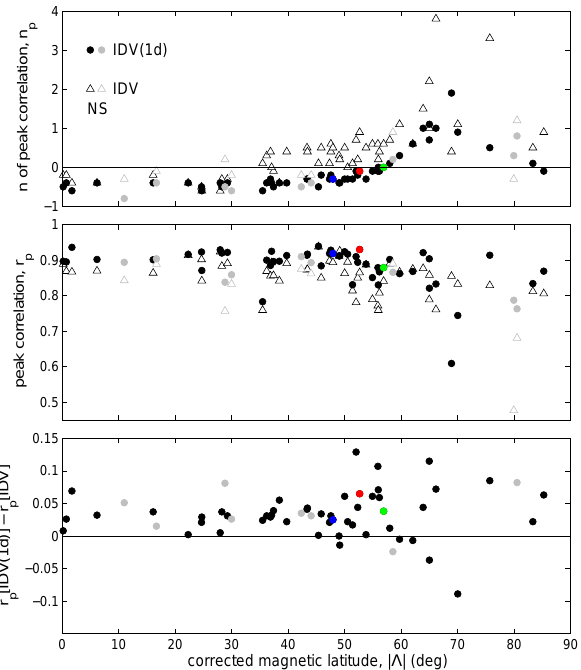
Fig. 4. Analysis of IDV(1d) variations with station corrected geo- magnetic latitude. (Top) The ratio f X = <IDV(1d) ESK /IDV(1d) X >; (bottom) the correlation with Eskdalemuir data, r E . The dashed line in the upper panel is the cos( 3 X ) variation employed by Bartels, the dot-dash line is the cos 0 . 7 (3 X ) variation employed for IDV by SC05 and the solid line is a seventh-order polynomial weighted fit given by Eq.